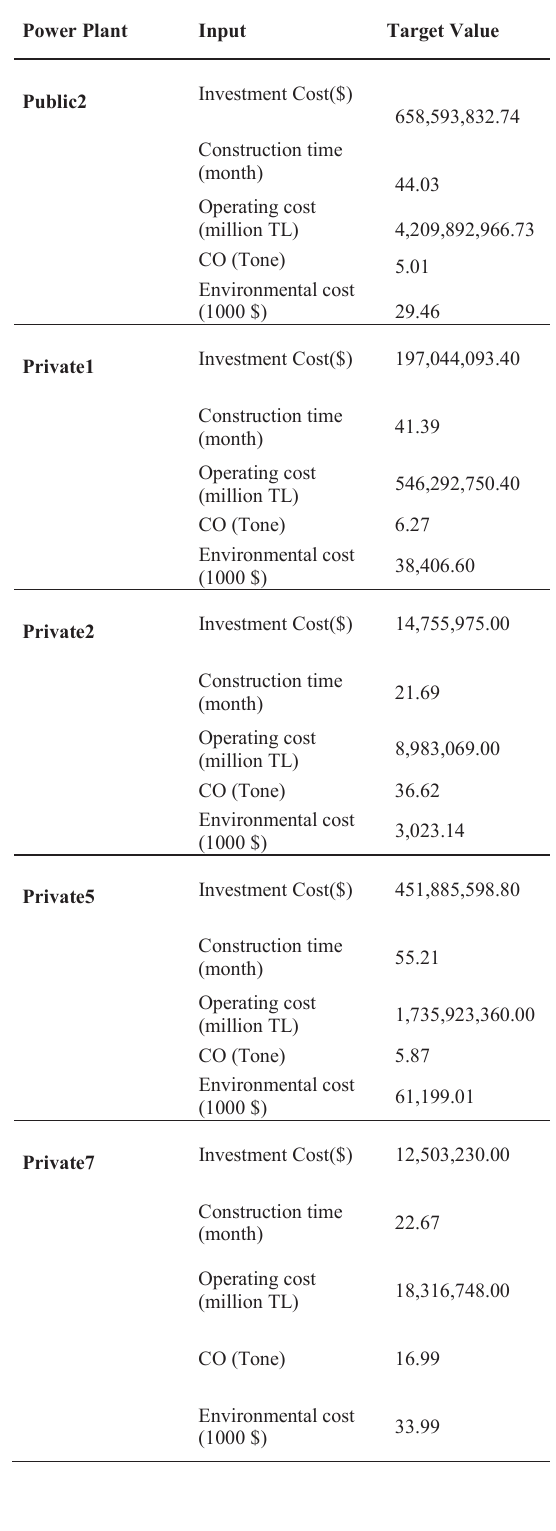
Table 3. New Efficiency Scores